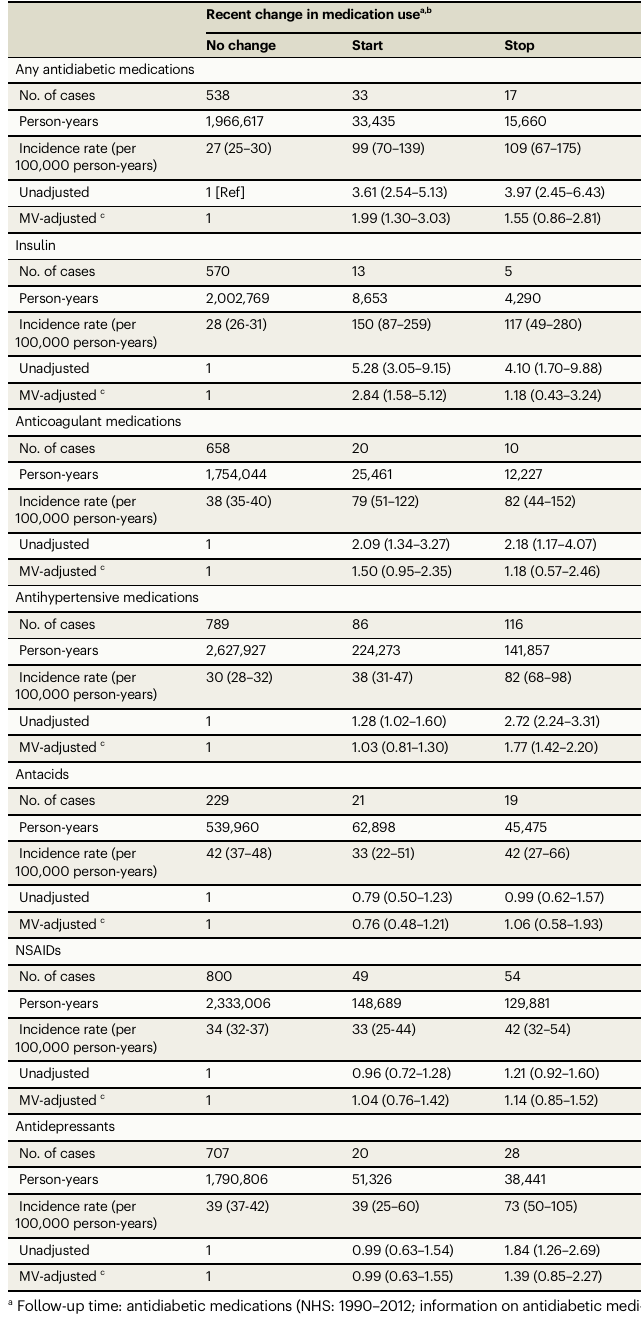
Table 1 | Recent change in medication use and 2-year risk of pancreatic cancer